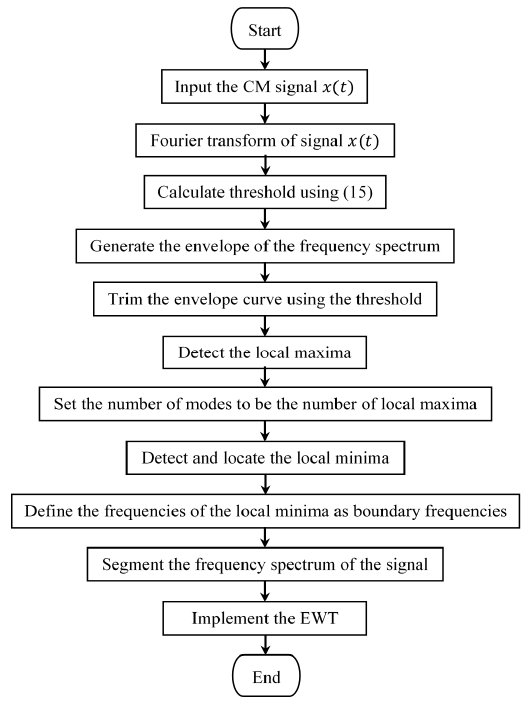
Figure 5. Flowchart of the enhanced EWT.